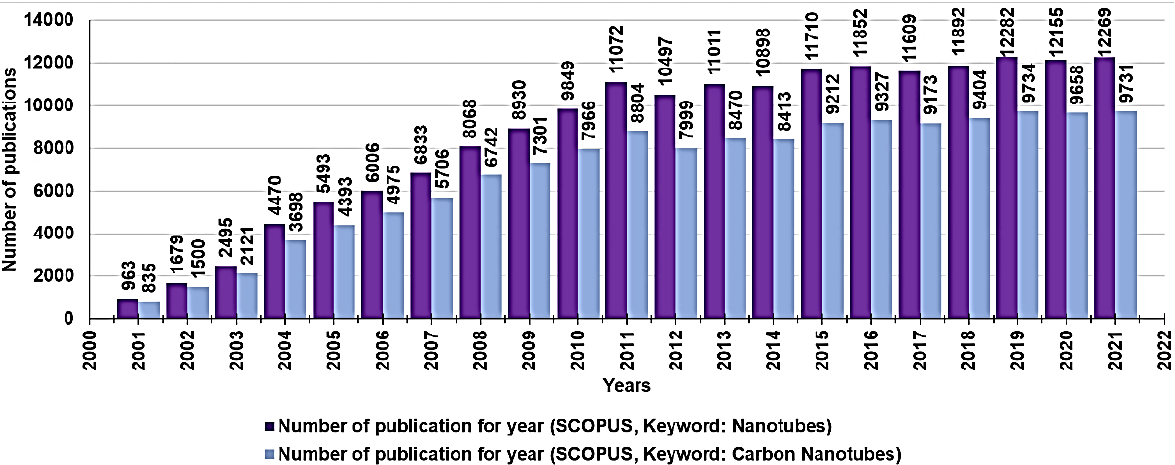
Figure 1. Number of publications per year during the last 20 years according to Scopus, concerning nanotubes (purple bars) and carbon nanotubes (light purple bars).